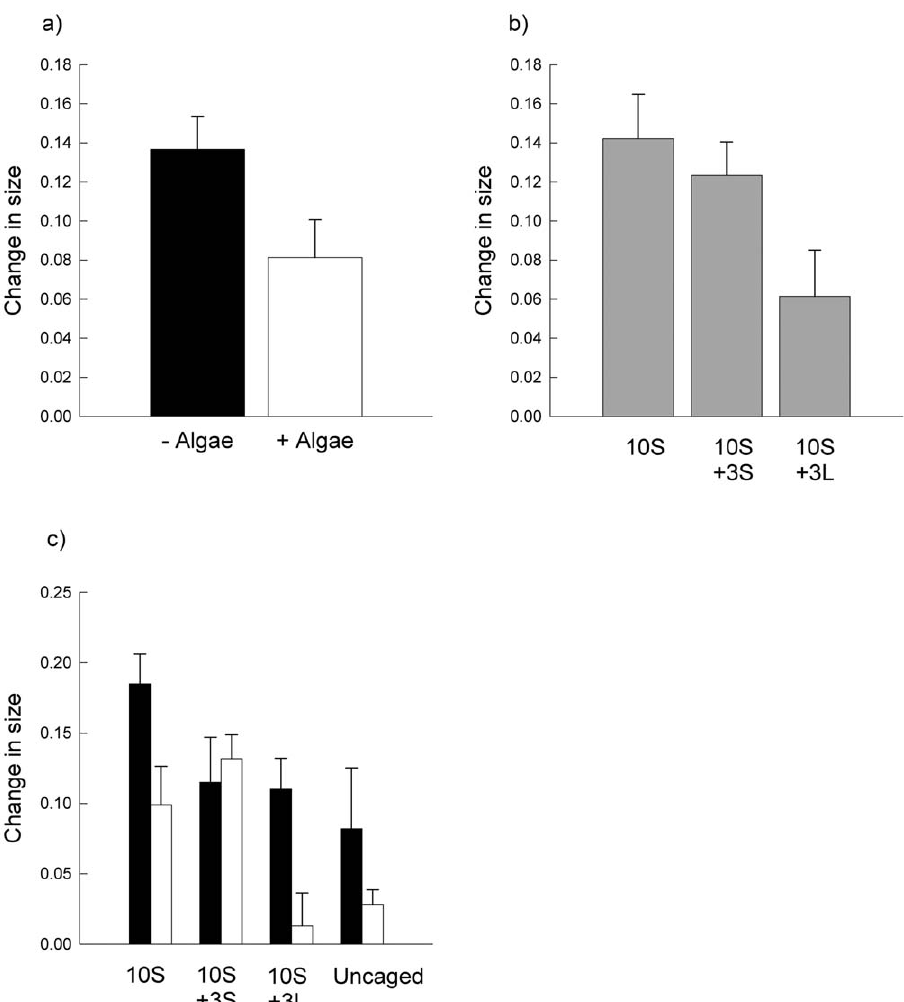
Figure 3. Changes in size of small limpets. Mean ( 6 SE) changes in size of small P. vulgata in absence (black bars) or presence (white bars) of macroalgae ( n =12; a), for each treatment ( n =8; b) or for both ( n =4; c) at the end of the experiment. S, small limpets; L, large limpets.